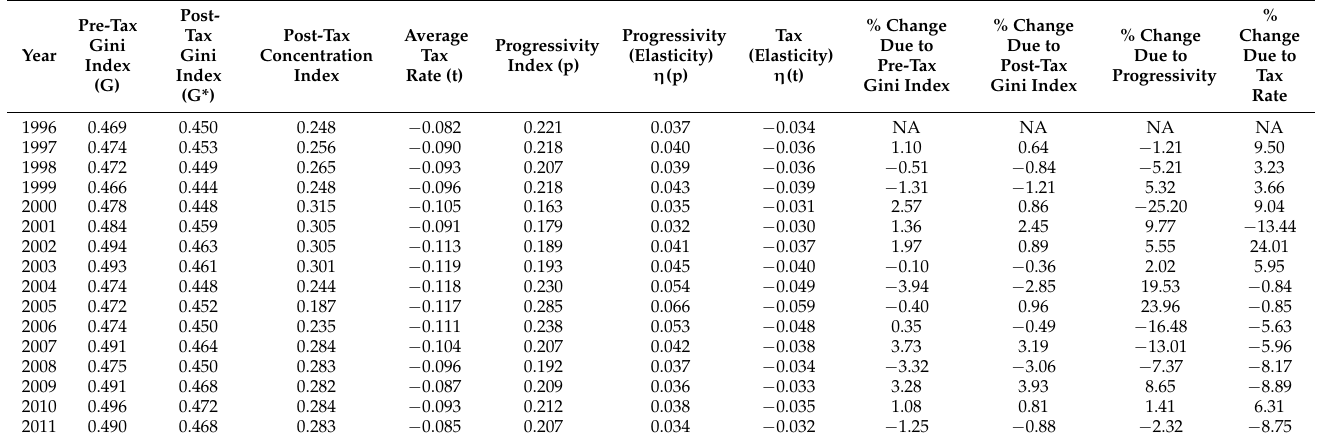
Table 1. Tax progressivity for all CPS respondents for years 1996 to 2011.